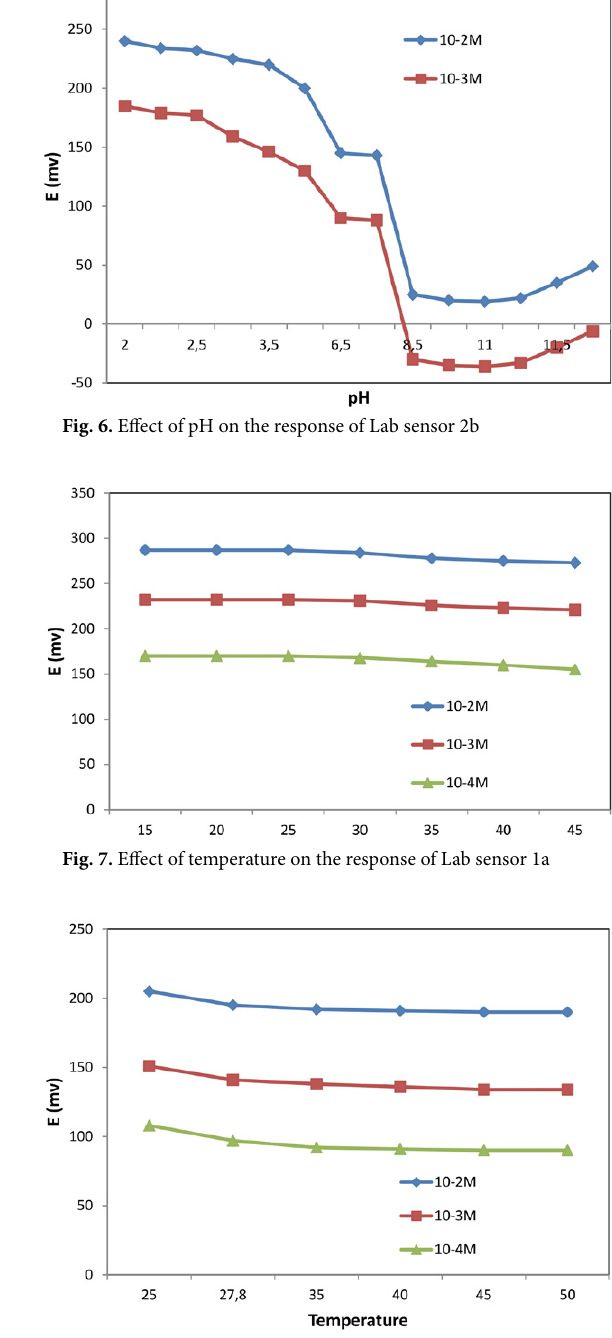
Fig. 5. Effect of pH on the response of Lab sensor 2a